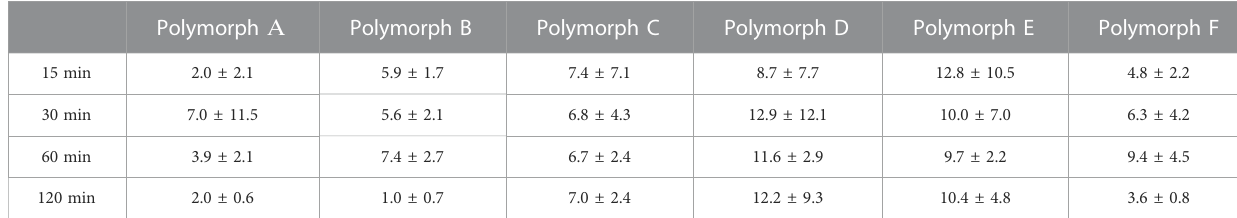
TABLE 4 The concentration of Polymorphs in blood serum, ng/ml, average values.